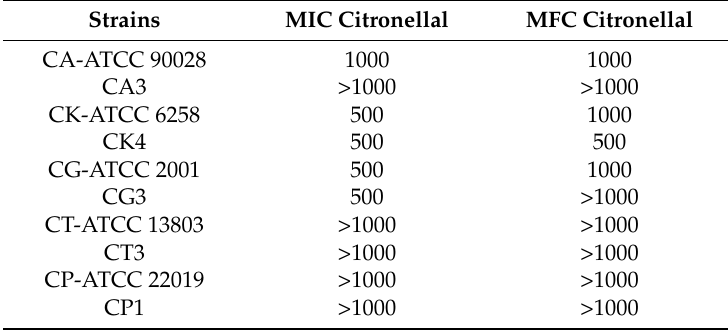
Table 3. Minimal inhibitory concentrations (MIC, µ g/mL) and minimal fungicidal concentration (MFC, µ g/mL) of citronellal against Candida